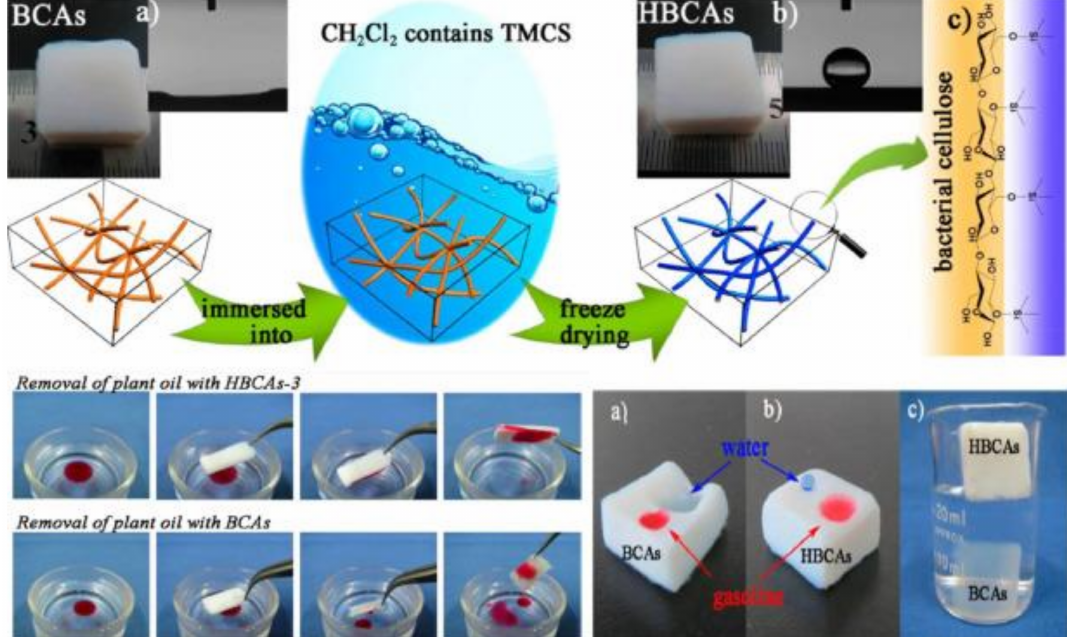
Figure 7. Surface hydrophobization of bacterial cellulose acetate membranes with trimethylchlorosilane for the efficient removal of plant oil from water [169], ©American Chemical Society (2015). BCA—bacterial cellulose acetate; TMCS— trimethylchlorosilane; HBCA—hydrophobic